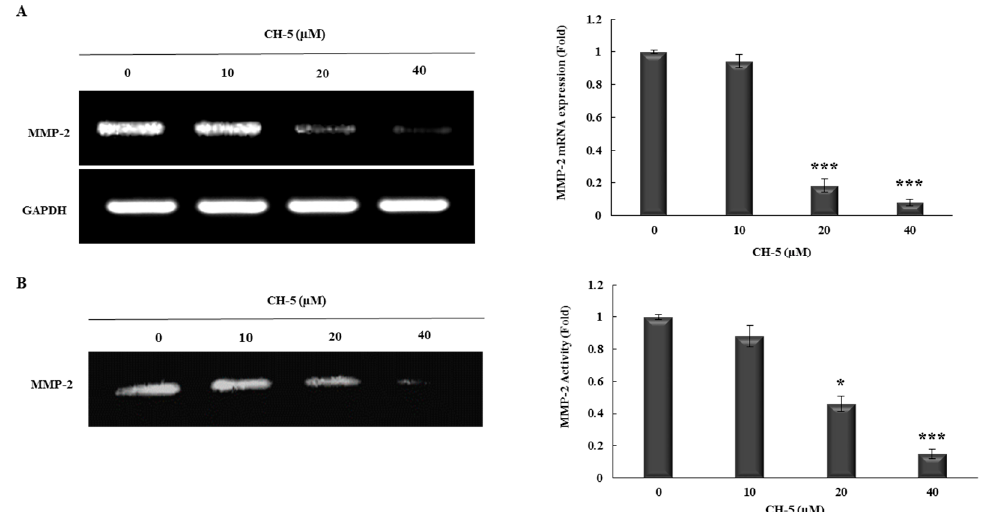
Figure 3. CH-5 decreased transcriptional levels and protease activity of MMP-2 in HGC-27 cells. ( A ) HGC-27 cells were treated with 0, 10, or 40 µM of CH-5; after 24 h the total RNA was isolated and then subjected to conventional RT-PCR using primers for MMP-2 and housekeeping gene GAPDH. A representative gel (left) and densitometry analysis from three independent experiments (right) are shown; ( B ) HGC-27 cells were treated with CH-5 (0, 10, 20, and 40 µM) for 24 h and then the activity of secreted MMP-2 was measured by gelatin zymography assay. A demonstrative gel (left) and quantitative results (right) from three independent experiments are presented. In all experiments, * p ≤ 0.05 and *** p ≤ 0.001 vs. DMSO-treated cells.